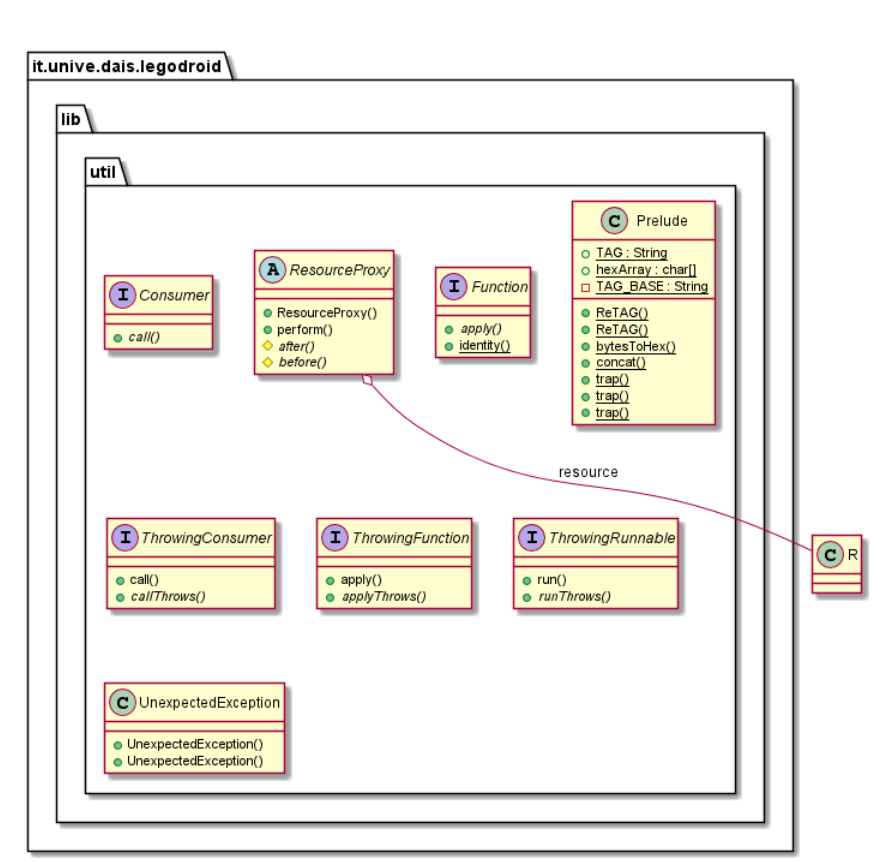
Figure 5. UML Class Diagram of package legodroid.lib.util